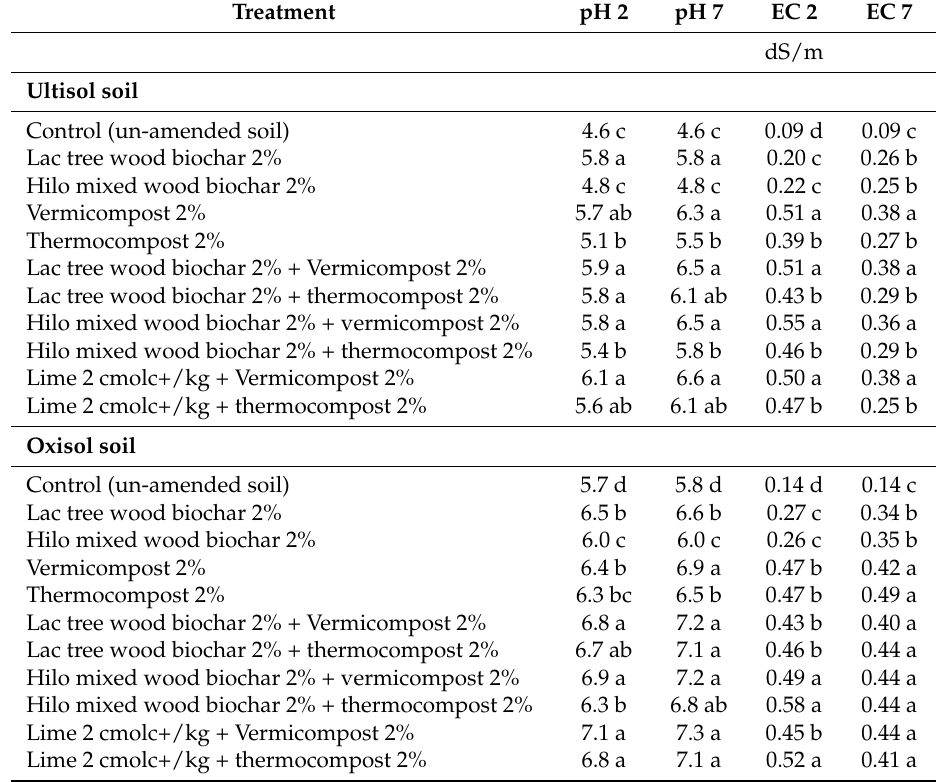
Table 3. Means and standard errors of pH and EC of the soils 2 and 7 weeks after being incubated with the biochars, lime and/or composts ( n =